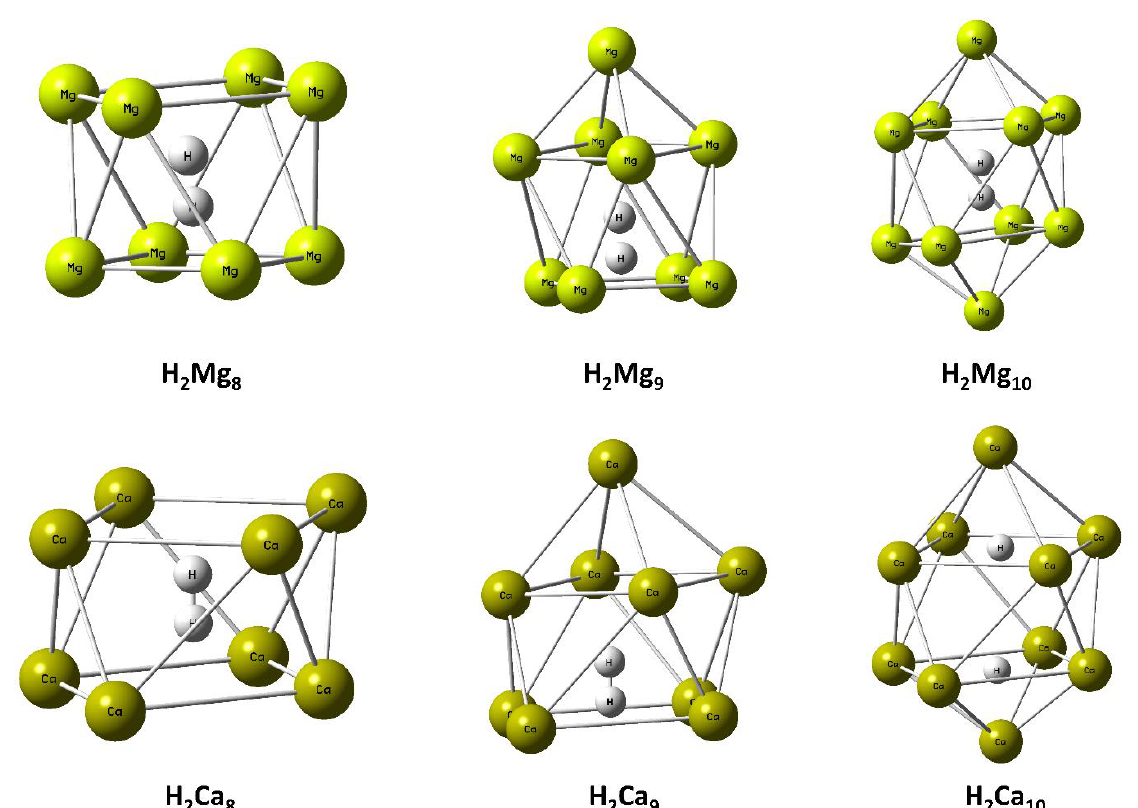
Figure 1. Optimized geometries of H 2 M n (where M = Mg, Ca; n = 8, 9, 10) clusters. This figure is reproduced from Reference [17].